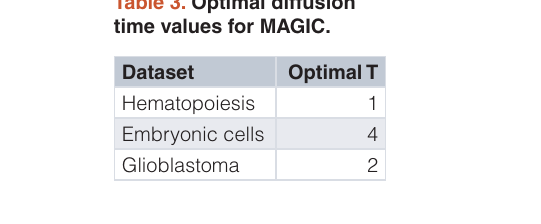
Table 3. Optimal diffusion time values for